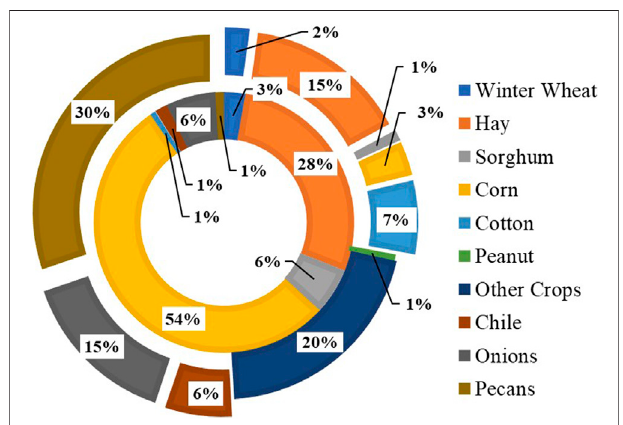
FIGURE 4 | Economic value (outer circle) and production (inner circle) of New Mexico crops in 2017.